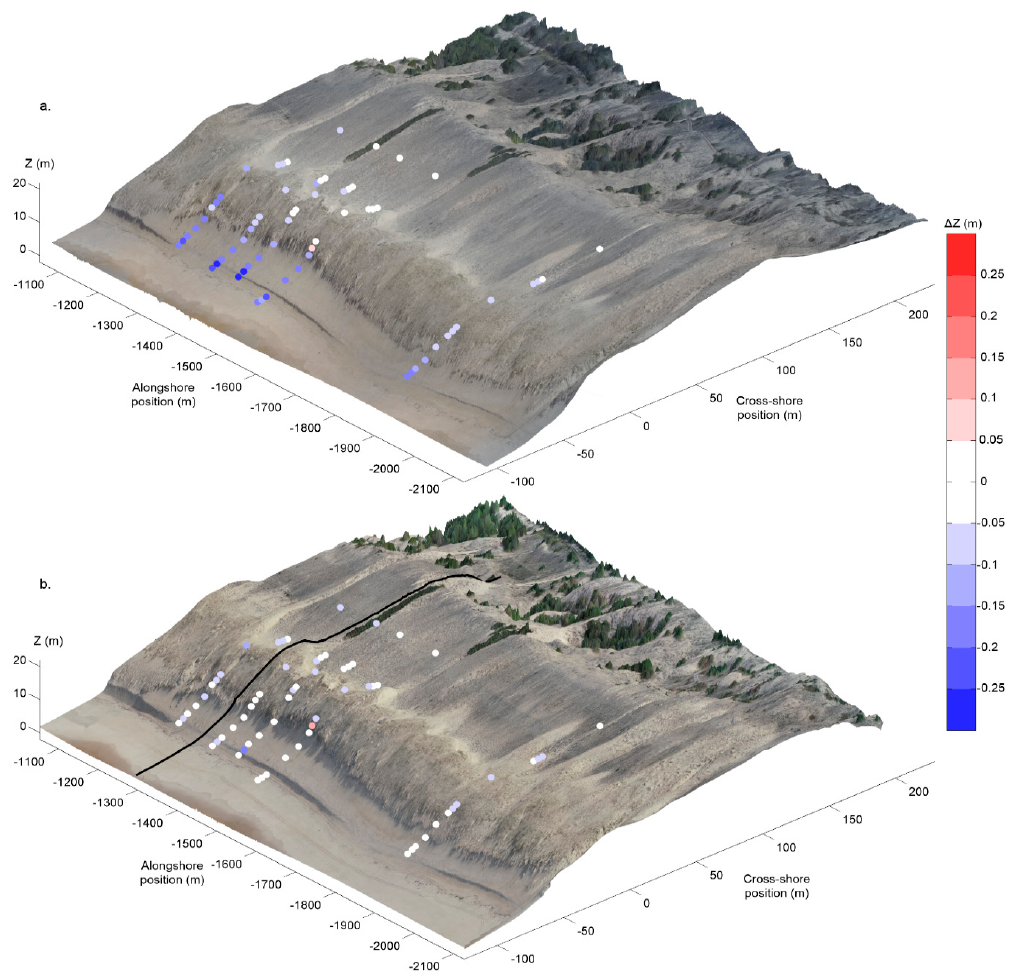
Figure 4. Elevation relative error (colored circles) between the DSM, generated using 10 GCPs, and the DGPS ground survey superimposed onto the 3D textured DSM for ( a ) DP2 and ( b ) DP4P. The DSM in ( a , b ) were generated with DP2 and DP4P images, respectively. The black line shows the cross-shore profile presented in Figure 5.